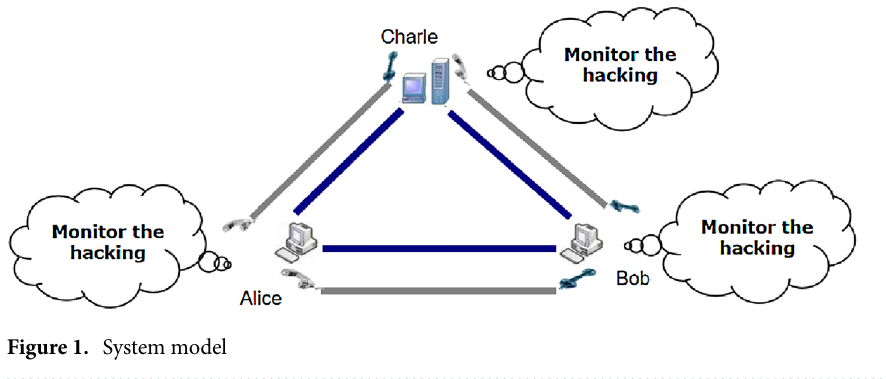
Figure 1. System